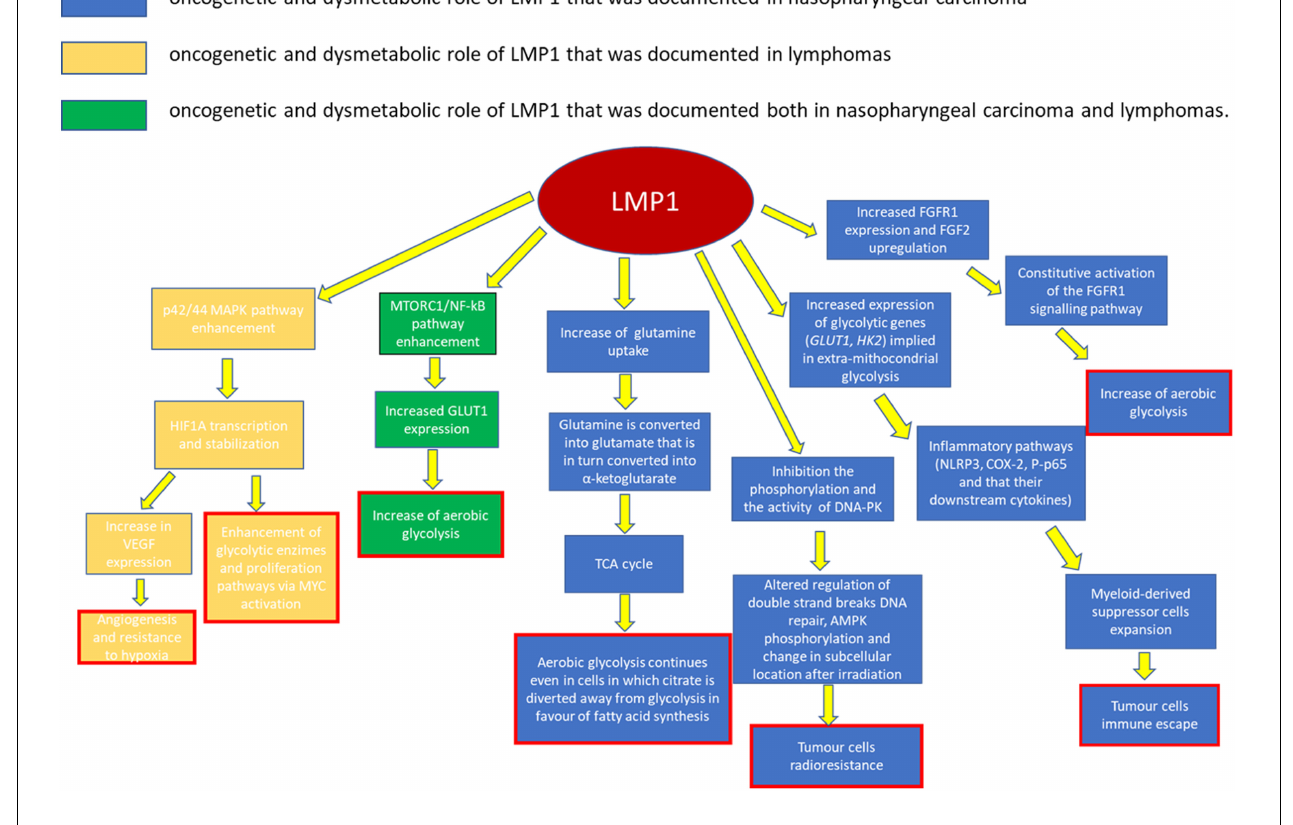
FIGURE 1 | Role played by LMP1 in